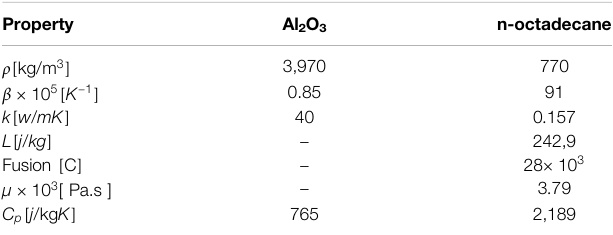
Table 1 | Properties of PCM and alumina.